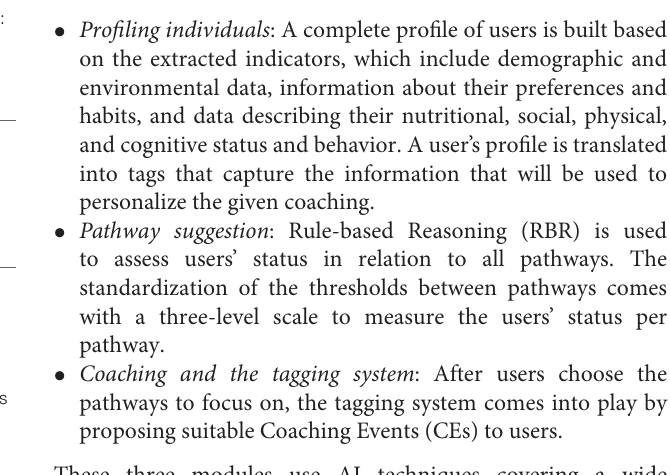
TABLE 2 | Business (BRS), Stakeholder (StRS), and System Requirements Specifications (SRS). BRS StRS